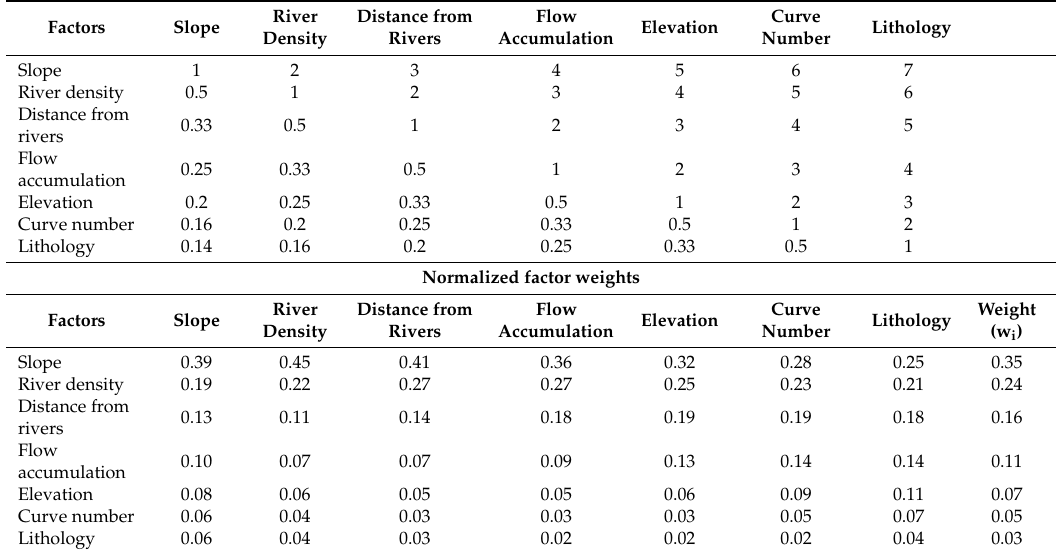
Table 4. Pair-wise comparison matrix, normalized factor weights, and final weights (w i